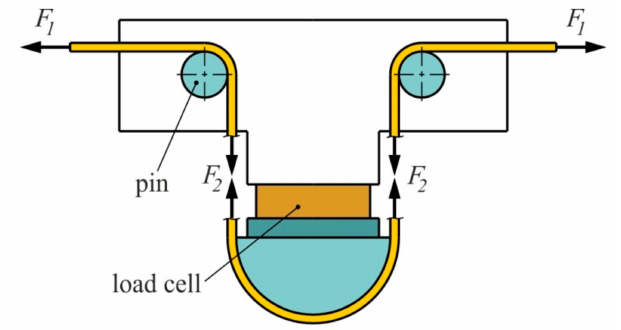
Figure 26. Schematic of the “U” shape strip test, prepared based on